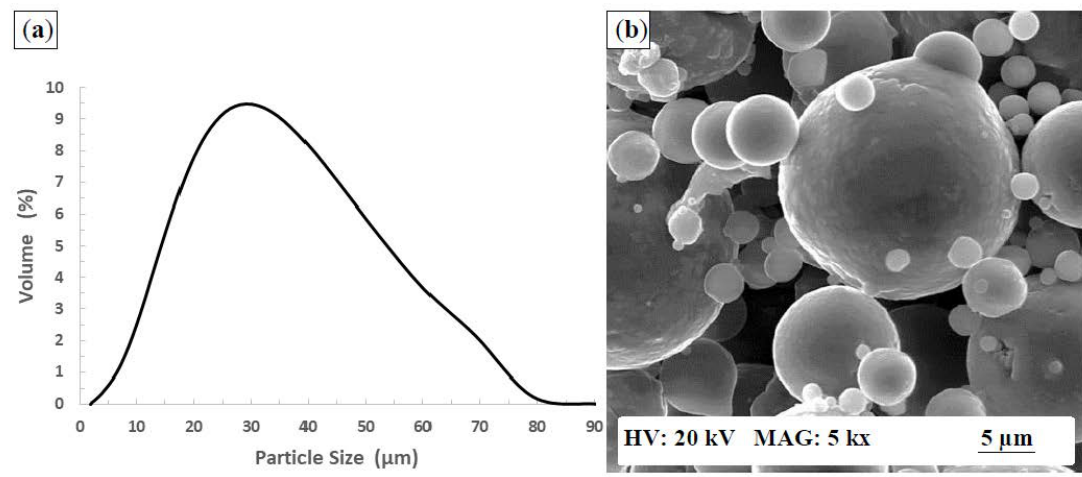
Figure 1. ( a ) Particle size distribution (PSD) of the AlSi10Mg powder; ( b ) SEM observations of the powder morphology. Table 1. The energy dispersive X-ray spectroscopy (EDS) measurements for the weight% of the chemical composition elements of the AlSi10Mg powder.